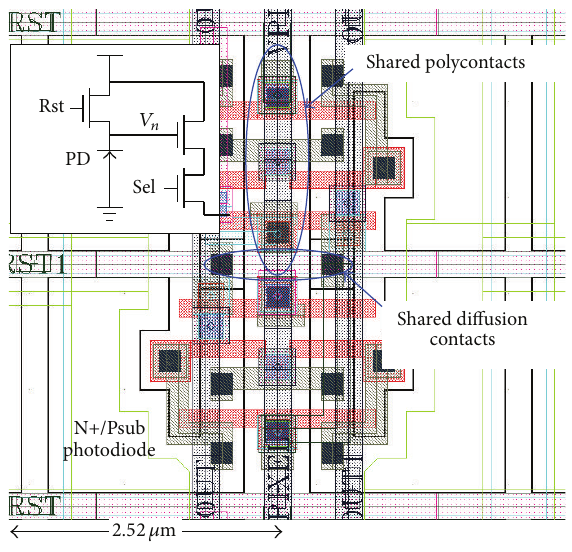
Figure 9: The pixel layout.